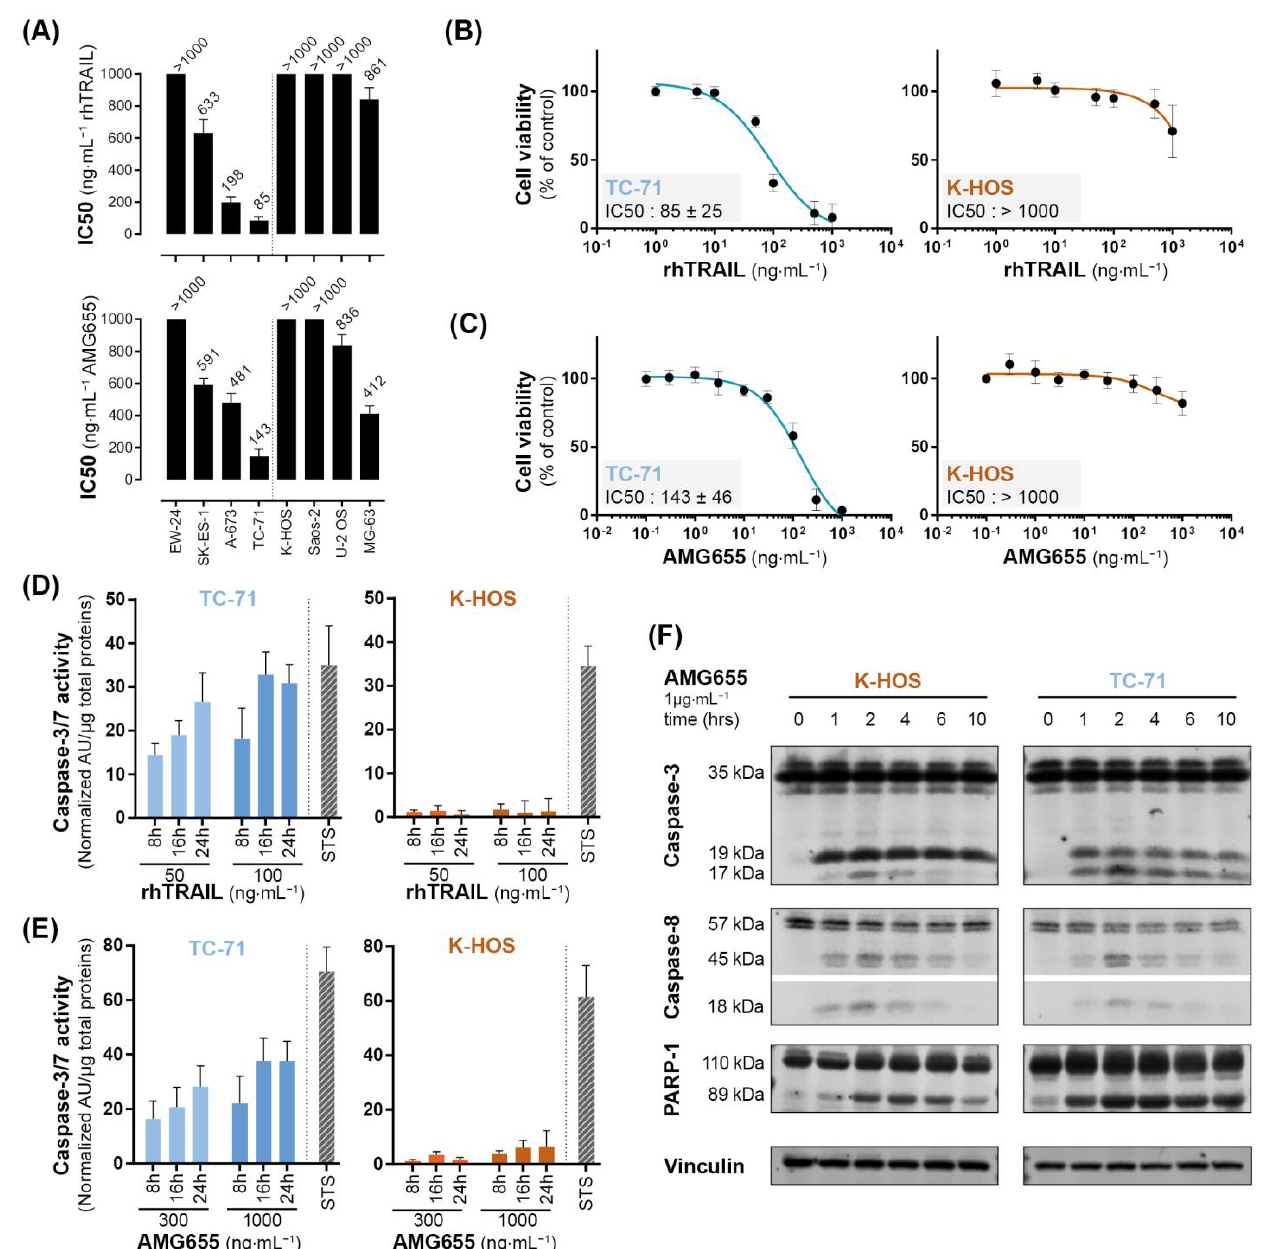
Figure 1. Osteosarcoma and Ewing sarcoma cell lines show discrepancy in sensitivity to the pro- apoptotic effect of rhTRAIL and of the DR5-agonist AMG655. ( A ) rhTRAIL and AMG655 IC50 of 4 osteosarcoma and 4 Ewing sarcoma cell lines. Cells were cultured for 72 h in the presence of increasing concentrations of rhTRAIL or AMG655; viability was determined by crystal violet staining. IC50 were calculated with GraphPad Prism software. As an illustration, viability curves of TC-71 (EWS) and K-HOS (OS) cell lines in the presence of ( B ) rhTRAIL or ( C ) AMG655 are shown. ( D ) Sensitivity to rhTRAIL- and ( E ) to AMG655-induced apoptosis was assessed by specific enzymatic assay of caspase-3/7 activity. Cell lines were treated with either 50 and 100 ng ⋅ mL −1 of rhTRAIL or 300 and 1000 ng ⋅ mL −1 of AMG655; total proteins were extracted 8 h, 16 h, or 24 h after treatment. The caspase-3/7 enzymatic activity was measured by Apo-ONE ® Homogeneous Caspase (Promega); the results were normalized to total protein. Staurosporine 1 µM (STS) treatment for 8 h was used as positive control of apoptosis induction. ( F ) Kinetics of caspase-8, caspase-3 and PARP-1 cleavages in K-HOS OS cell line and TC-71 EWS cell line following 1, 2, 4, 6, and 10 h of treatment with 1 µg ⋅ mL −1 AMG655 determined by Western blot. Vinculin was used as loading control.